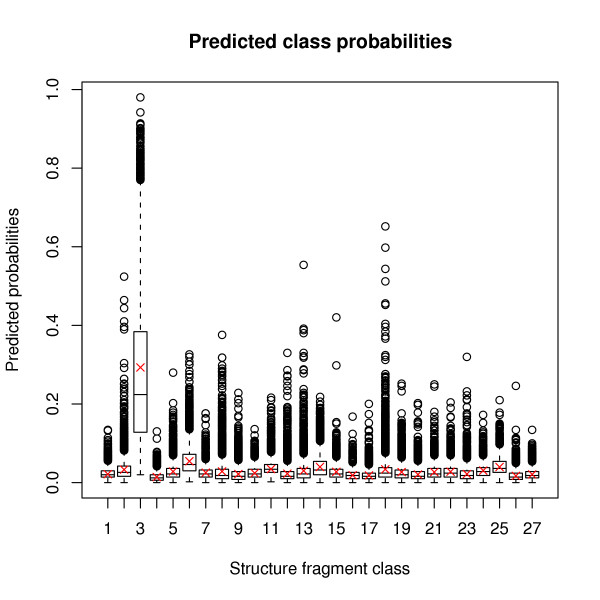
Boxplot of probability estimates (RF classifier). The boxes range from the first to the third quartile. The lines within the boxes denote the medians, the whiskers extend to the maximum and minimum values unless they are outliers, outliers are plotted as distinct circles. The red crosses indicate the prior class probabilities. (For presentation reasons, predictions for a subsample of the test set are shown).